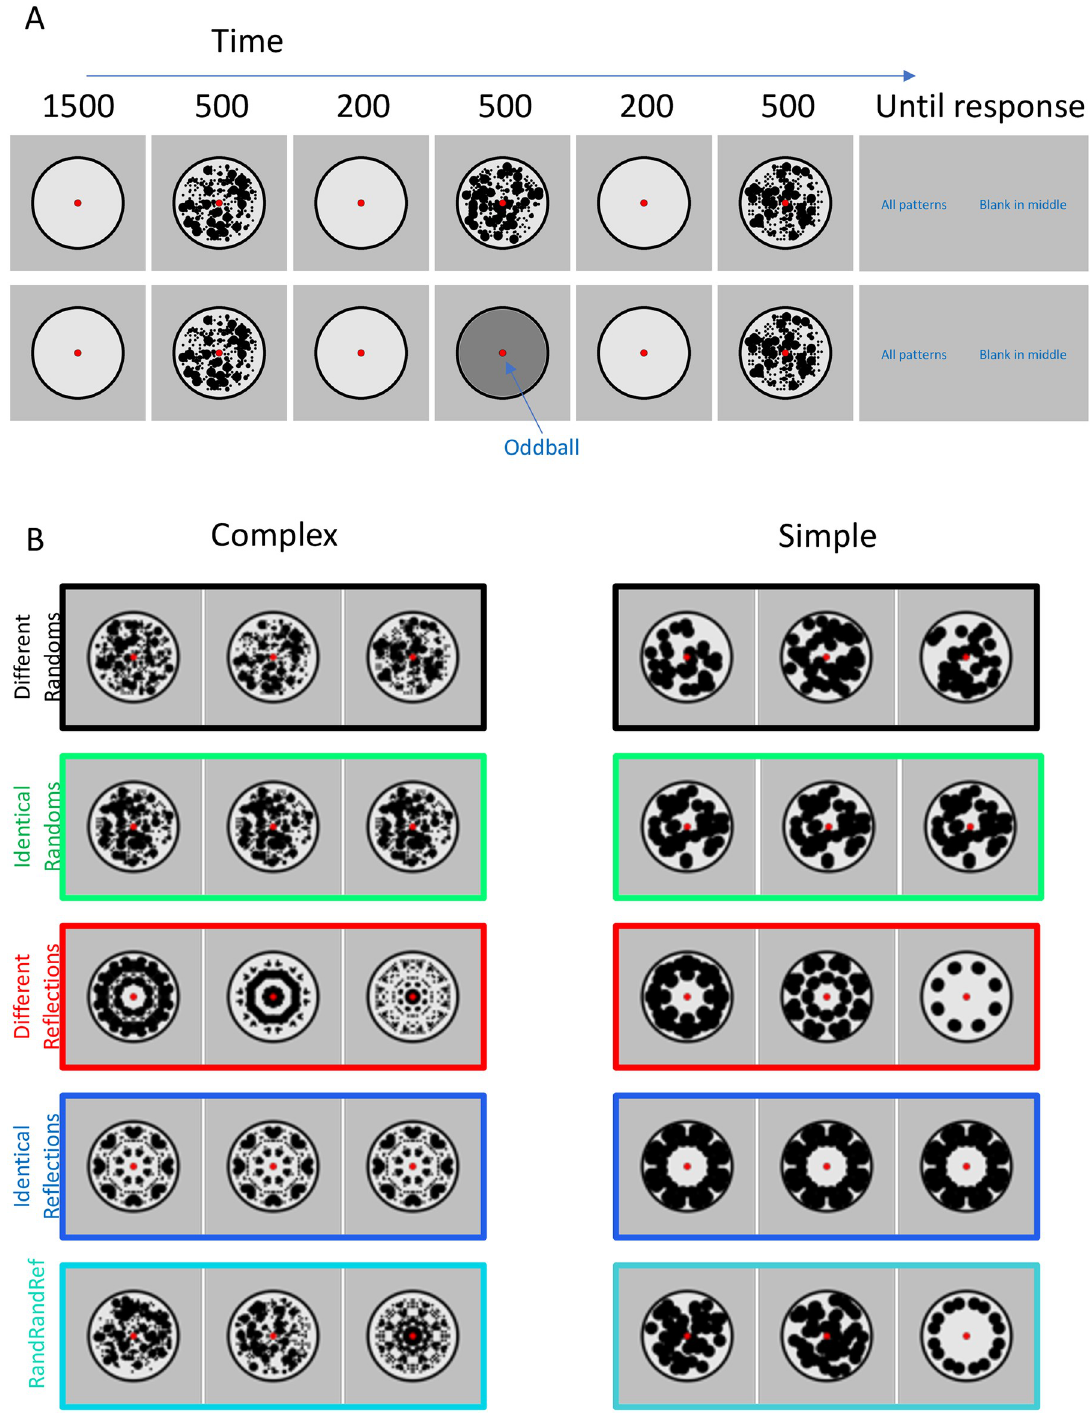
Fig 2. Experiment 1 method and stimuli. A) Trial structure in normal and oddball trials. All trials involved a sequence of three 500 ms presentations, separated by 200 ms gaps. Participants responded by pressing buttons for "All patterns" (all three presentations involved black and white patterns, as in the top row) or "Blank in the middle" (the second item in the sequence was blank, as in the lower row). B) Different triplets used. 24 participants were presented with complex patterns (left column) and another 24 were presented with simple patterns (right column). Individual patterns shown here are examples, in the real experiment each trial used different patterns. The coloured frames are matched with the colour of ERP waves in subsequent figures.